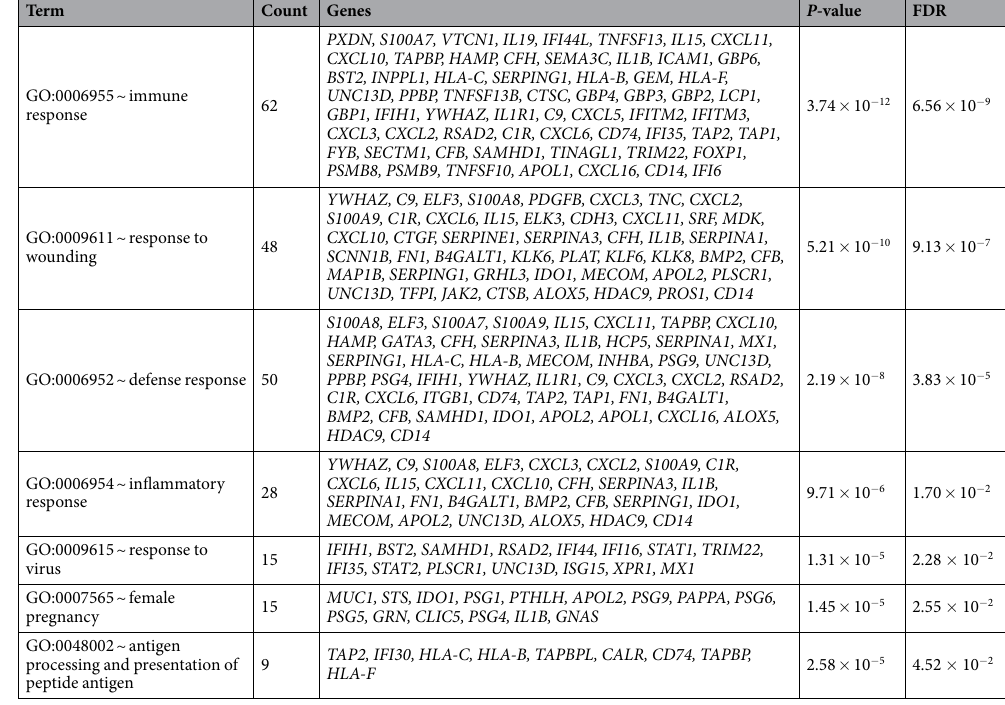
Table 2. Gene ontology enrichment analysis of genes highly expressed in EGF-treated LECs. FDR: false discovery rate <